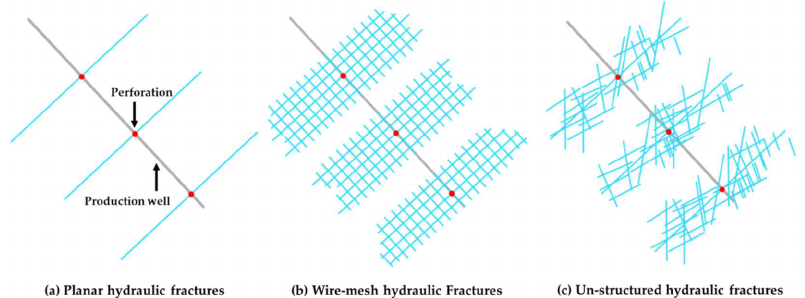
Figure 4. Illustration of various fracture geometry models to approximate a horizontal well. ( a ) Simple planar fractures (conventional approach), ( b ) wire-mesh hydraulic fractures, and ( c ) un-structured hydraulic fractures (UFM) [26]. Reproduced from [26], Cipolla: 2011.